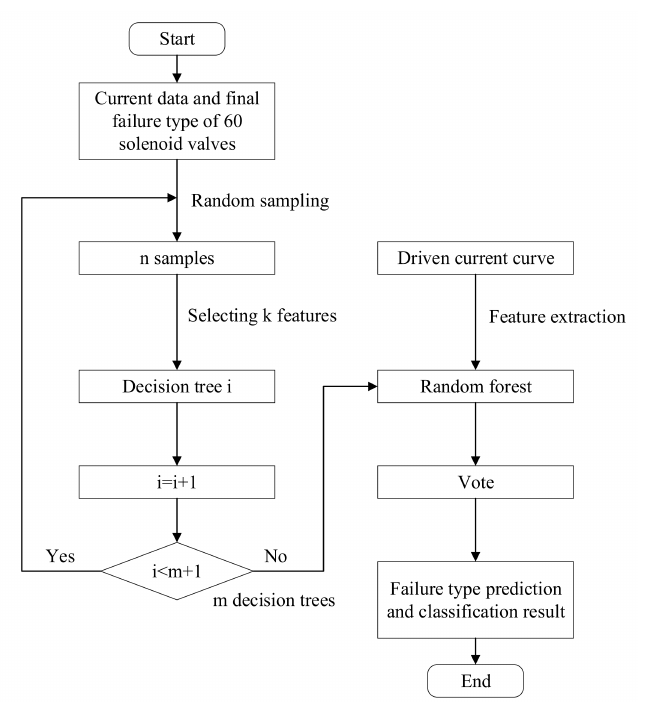
Figure 7. Algorithm flow of random forest applied to failure type prediction.